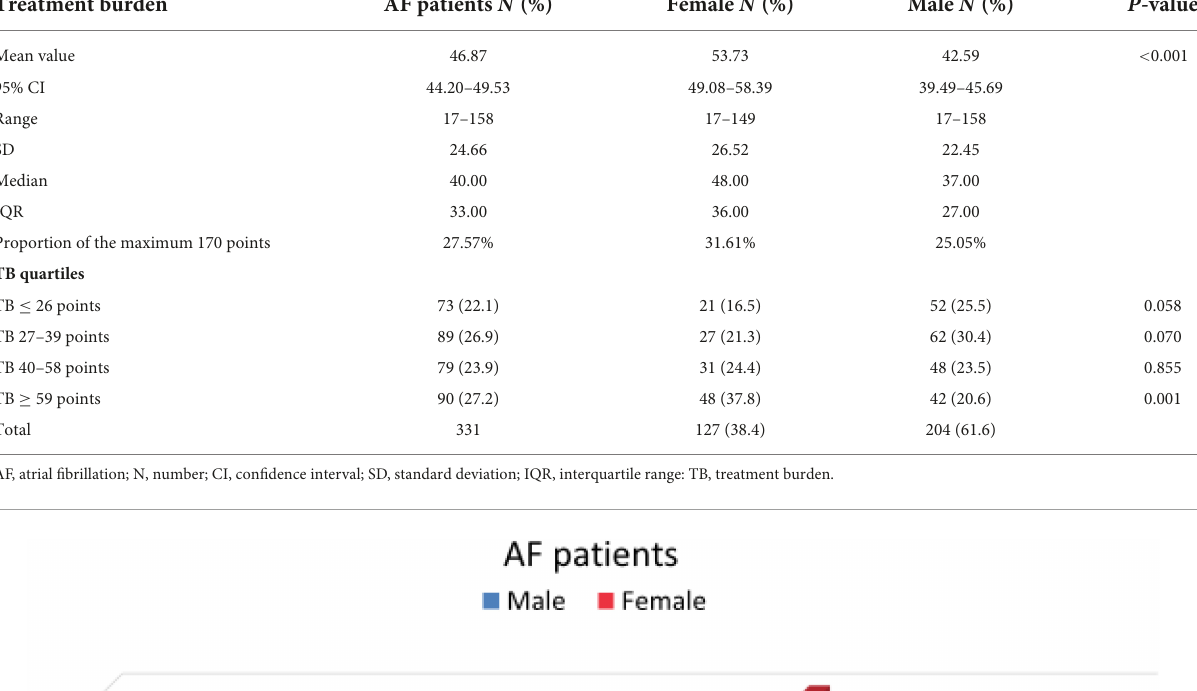
Overall, the mean EQ-5D score value was 2.95 points (14.75% of the maximum 20 points). Females reported significantly higher EQ-5D score (i.e., lower QoL) compared with males (3.97 vs. 2.32 points, P < 0.001), Table 4 . The EQ- 5D item-specific sex differences are shown in Supplementary Table 2 . Compared with males, female patients reported